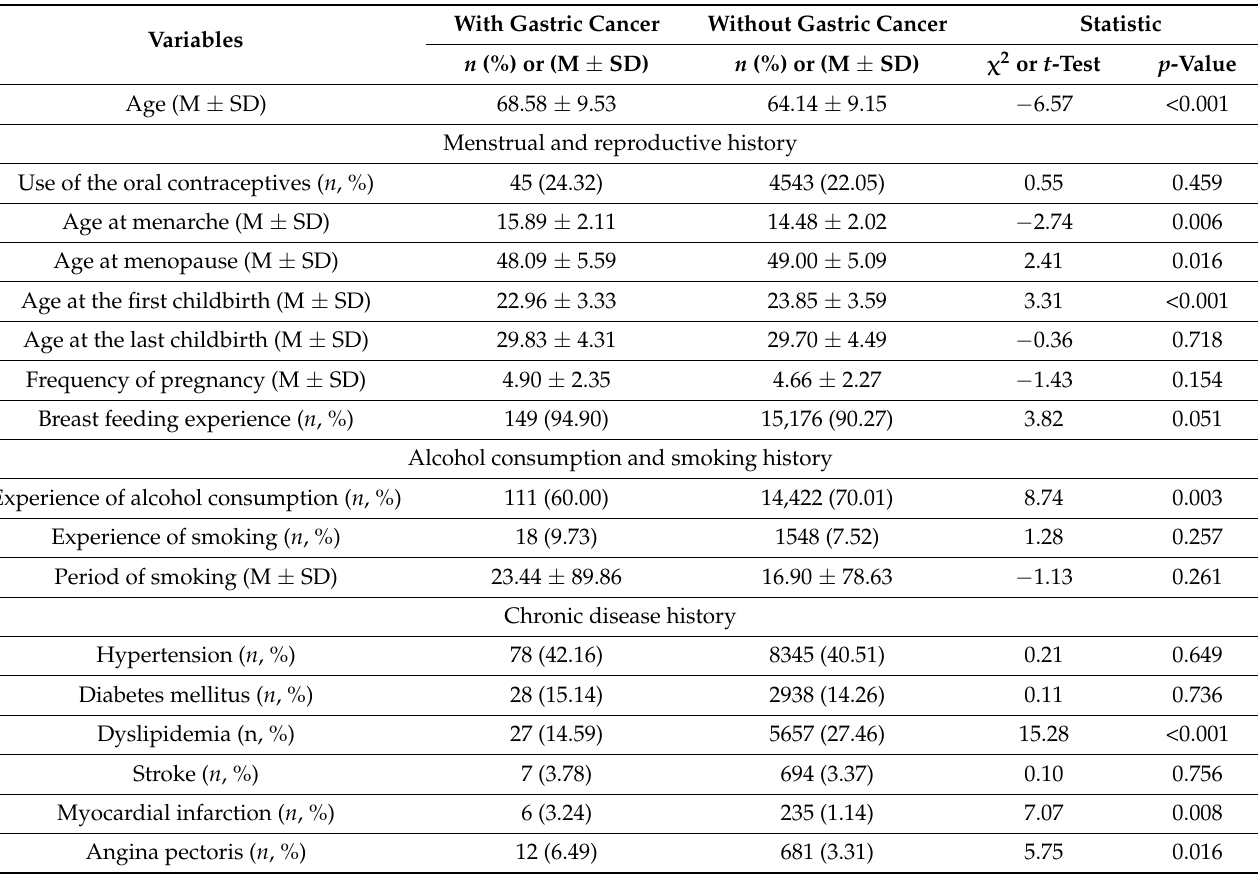
Table 2. General characteristics of